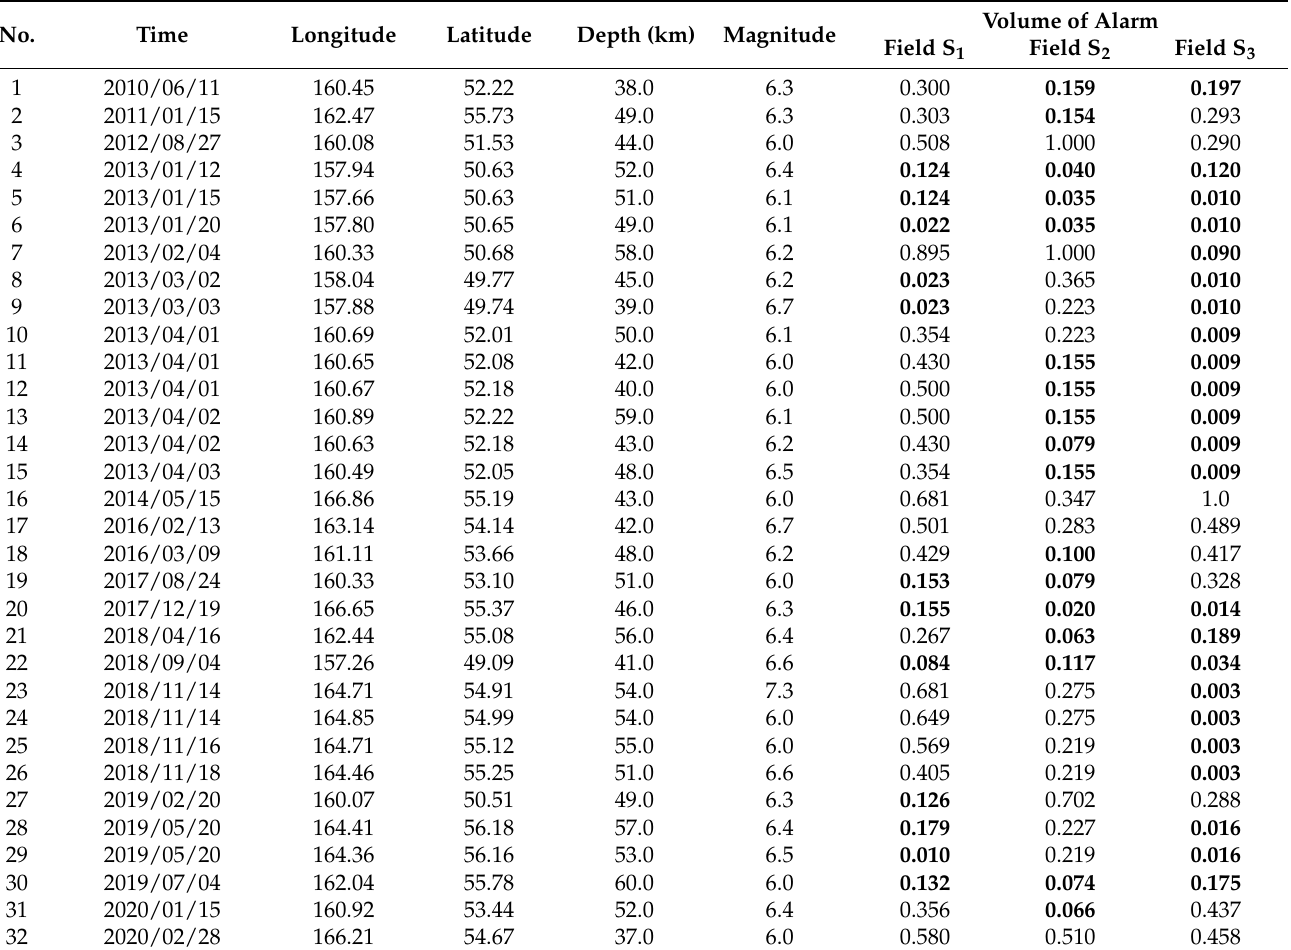
Table 2. Results of forecasting target earthquakes based on spatiotemporal fields of earthquake epicenter densities S 1 , S 2 , and S 3 .